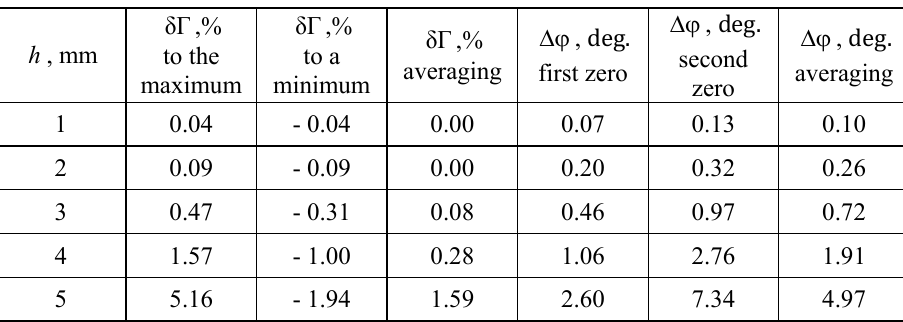
Table 2 . Calculations of measurement errors caused by imperfect probe at various depths of